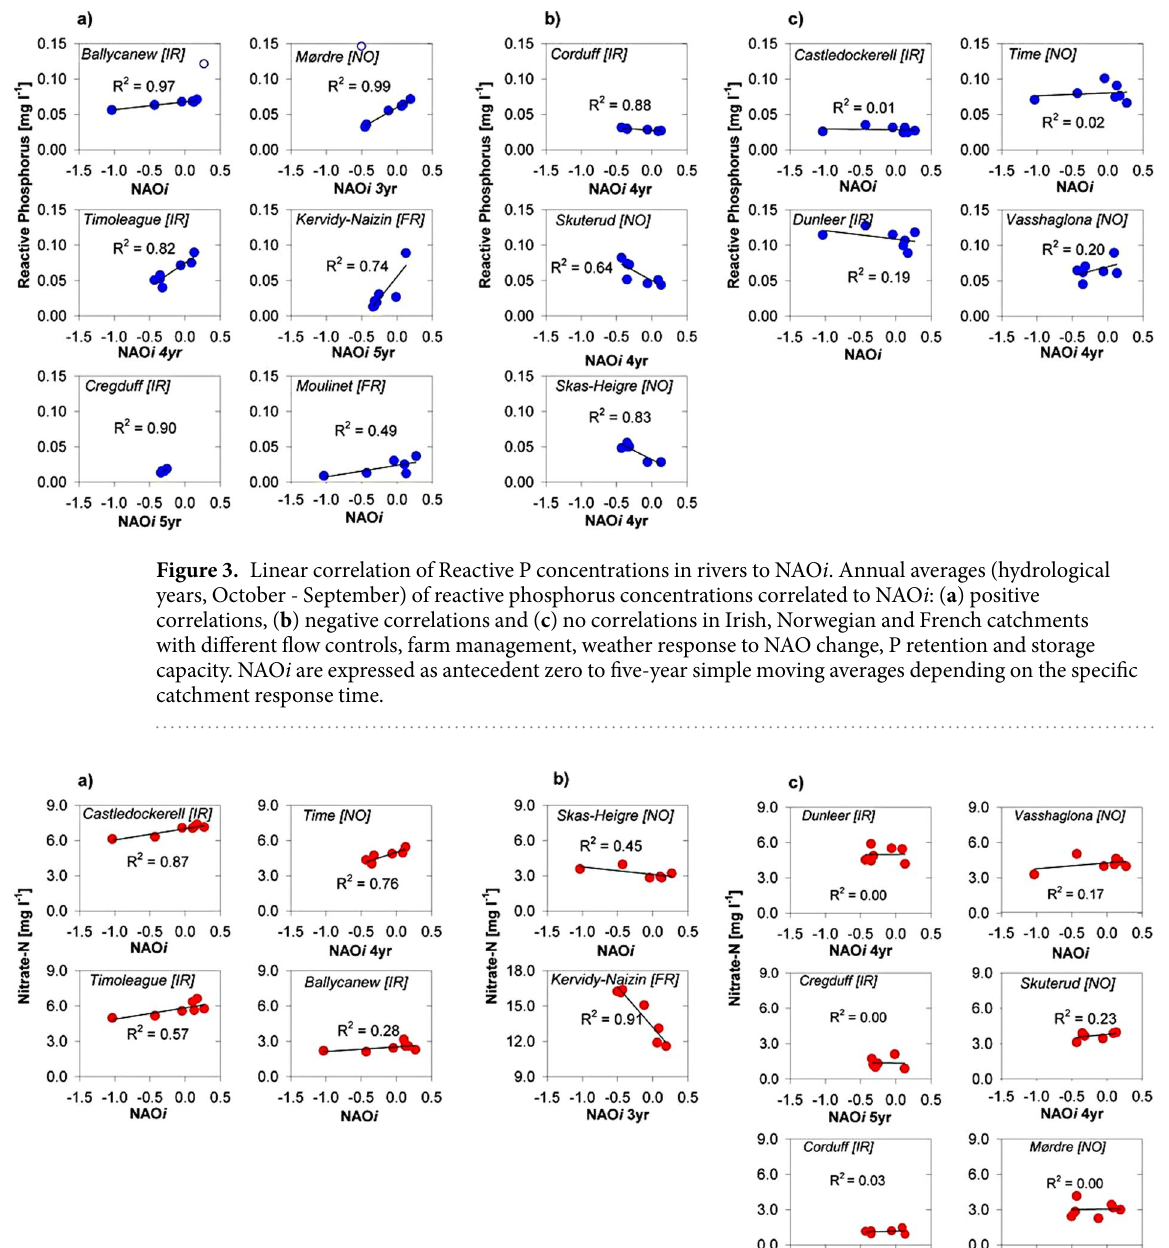
Fig. 4a–c and Table 2). The degree of correlation was viewed in terms of the two categories described above (mobilisation, transfer pathway, storage, attenuation, hydrological connectivity and dilution). The influence of changes in fertilizer application to the fields of the catchments was seen to be of minor importance for P and N concentrations during the analysed period and further dampened by the release of legacy P and N 48 . In some catchments, P and N concentrations were positively correlated to the NAO i (P: R 2 = 0.49–0.99 (n = 6) and N: R 2 = 0.28–0.87 (n = 6)) and in other catchments there were negative correlations (P: R 2 = 0.64–0.88 (n = 4) and N: R 2 = 0.45–0.91 (n = 2)), poor or no correlation (P: n = 4 and N: n = 6). Since the catchments response may present